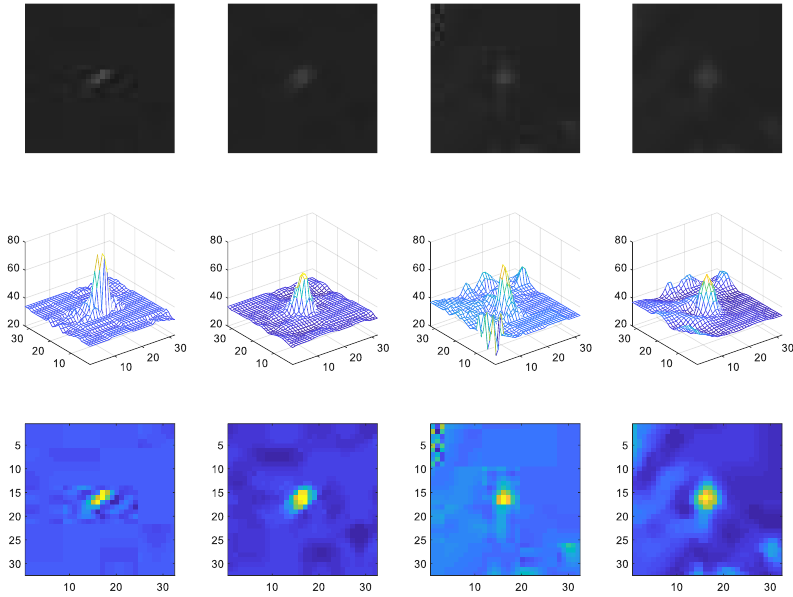
Figure 2. Gray distribution comparison before ( left ) and after ( right ) reconstruction of ship target and broken clouds.